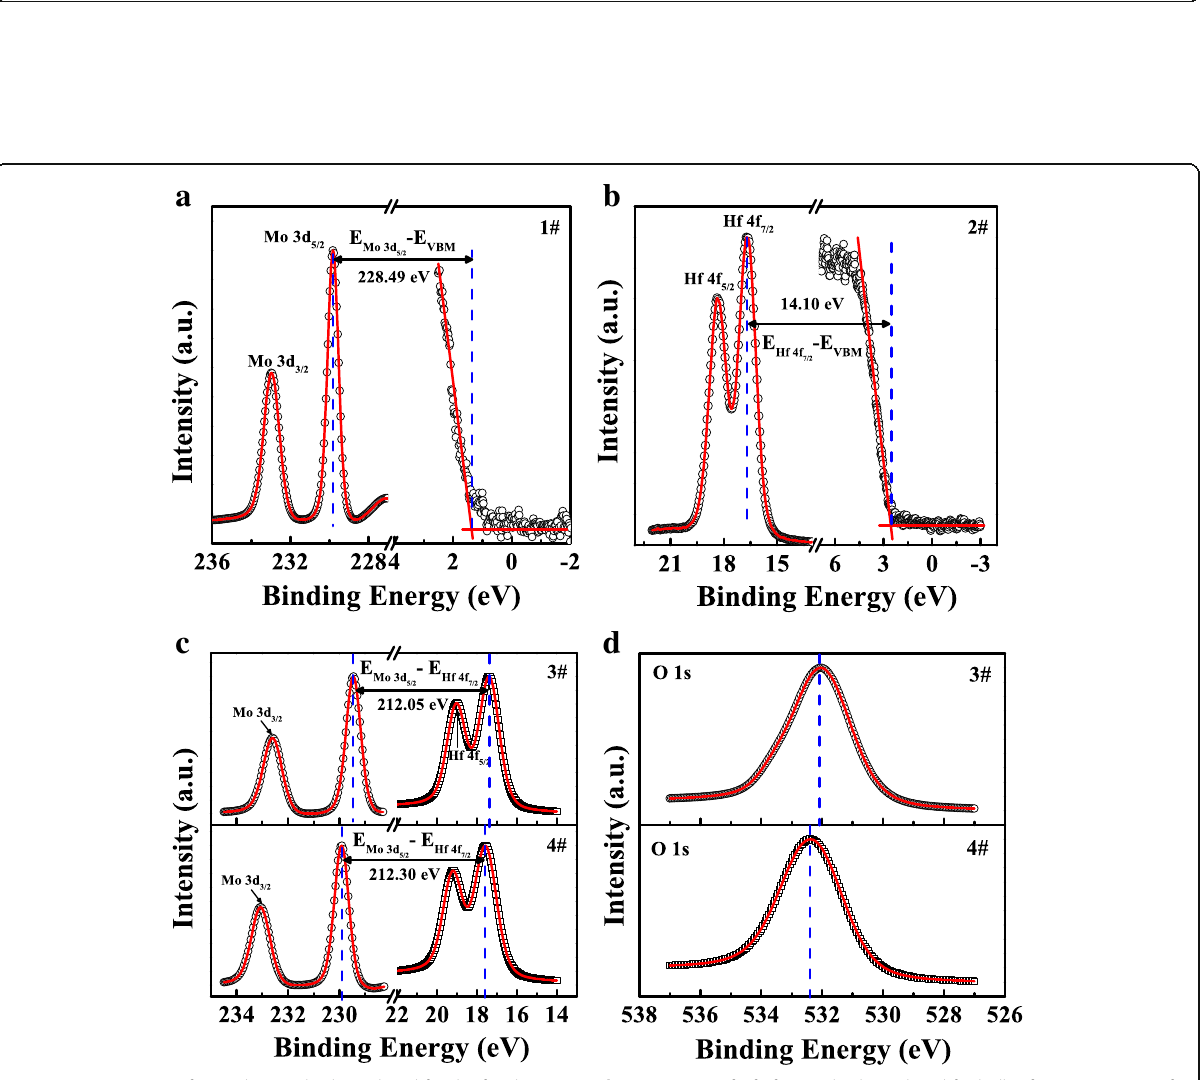
Fig. 3 a XPS spectra of Mo 3d CL and valence band for the few-layer MoS 2 . b XPS spectra of Hf 4f CL and valence band for bulk HfO 2 . XPS spectra of c Mo 3d, Hf 4f, and d O 1s CLs for transferred MoS 2 film on bulk HfO 2 with/without nitridation treatment